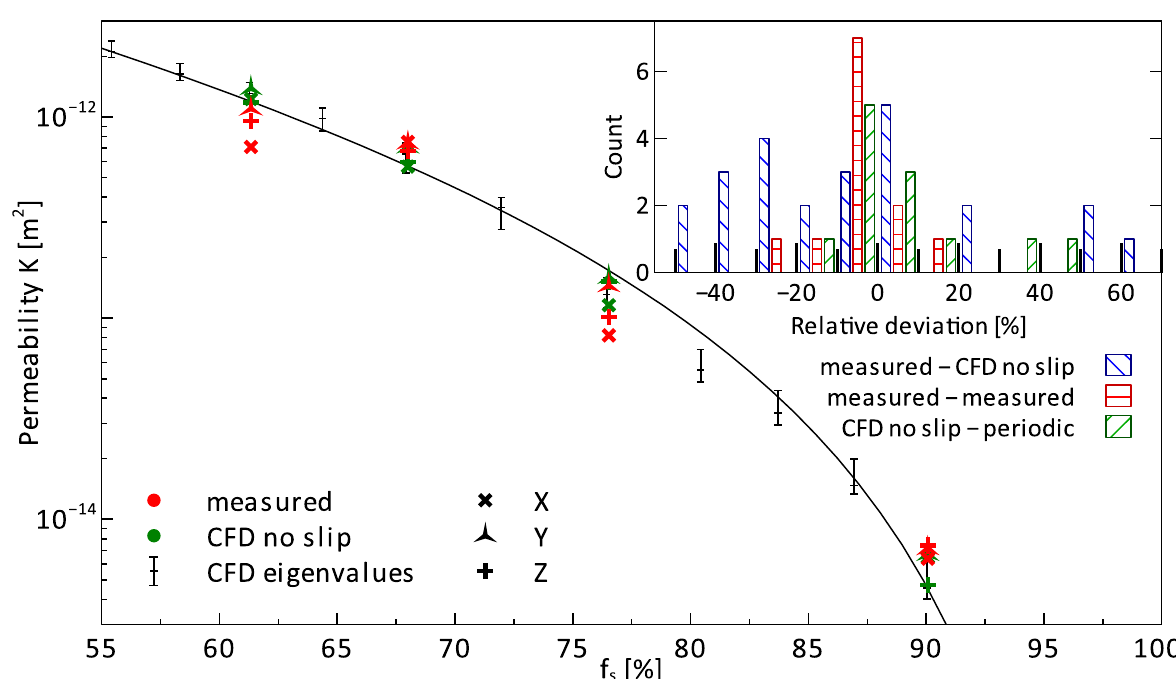
Figure 5. Comparison of predicted and simulated permeabilities of equiaxed dendritic microstructures at selected fraction solids. Inset: bar plot of relative differences between permeability results (first cited is the reference for relative deviation).